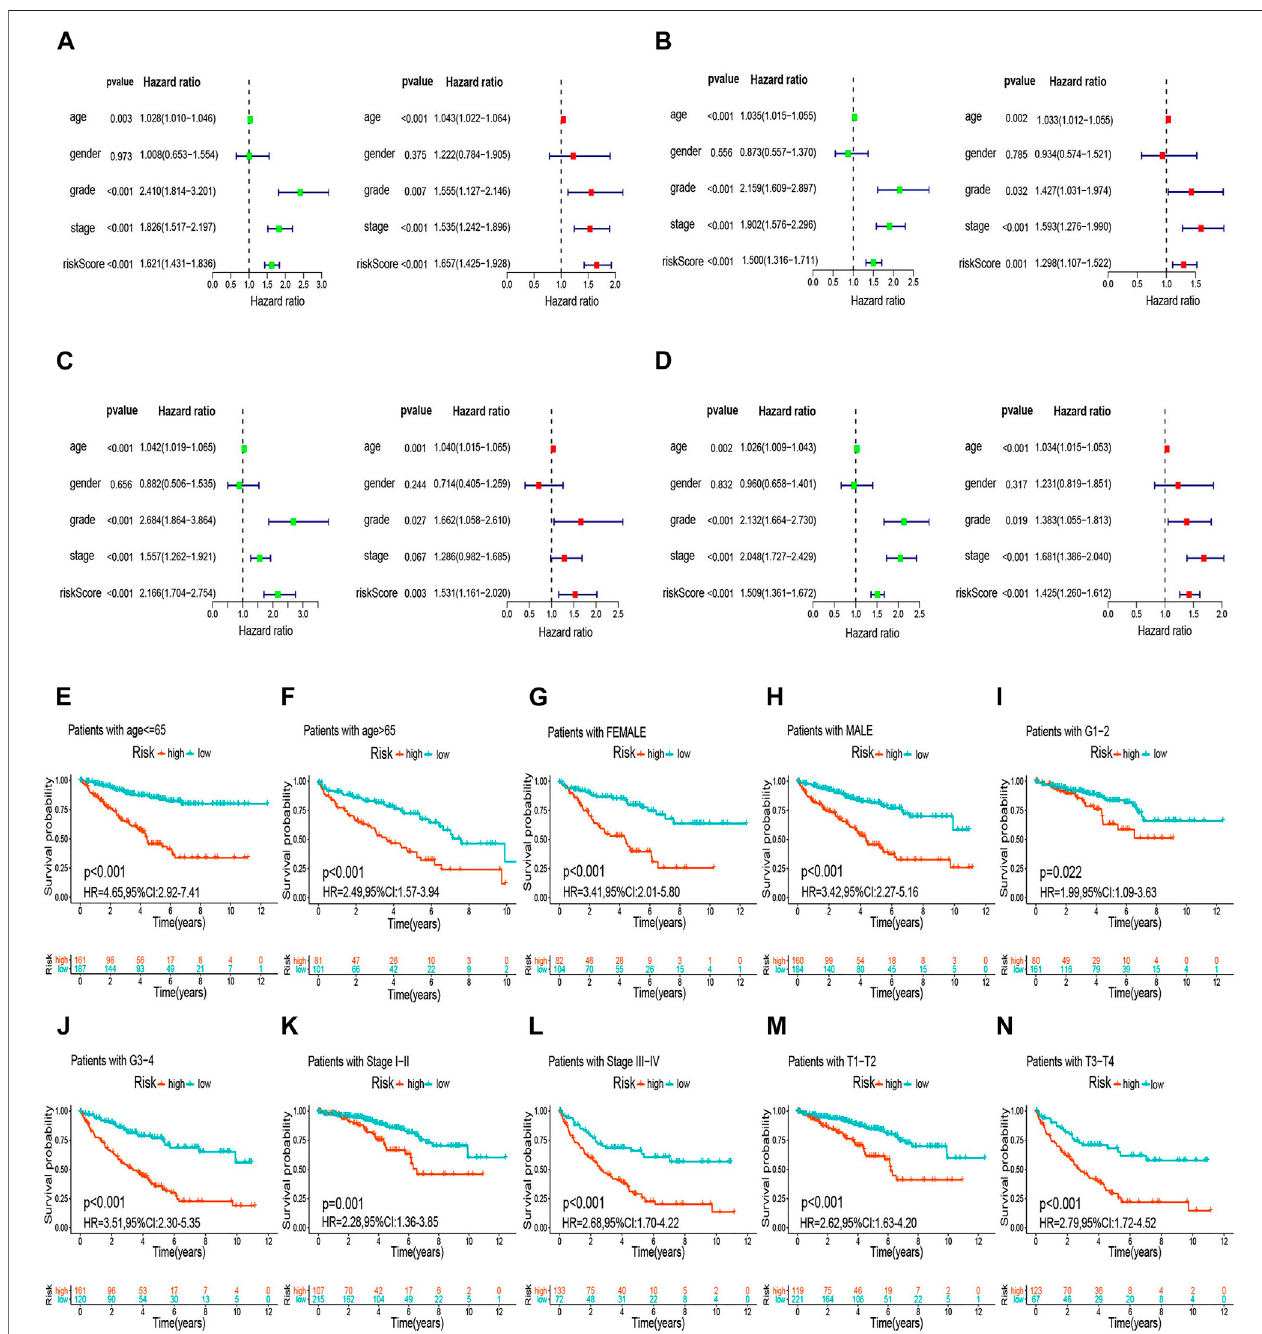
FIGURE8| Them6A-RLPSisanindependentprognosticindicatorforoverallsurvival(OS).Univariableand multivariate Coxregressionanalysesinthetraining (A) , fi rst (B) , second (C) , and third (D) validation cohorts. Analysis of OS strati fi ed by age (E, F) , sex (G, H) , tumor grade (I, J) , clinical stage, (K, L) , and T stage (M, N) .